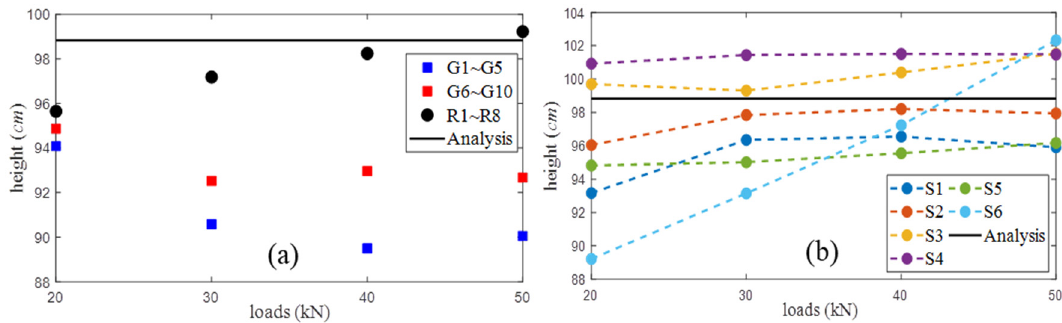
Figure 13. ( a ) The mean heights of neutral axis determined by transducers, gauges, and analysis, and ( b ) the neutral axis heights corresponding to each source excitation.